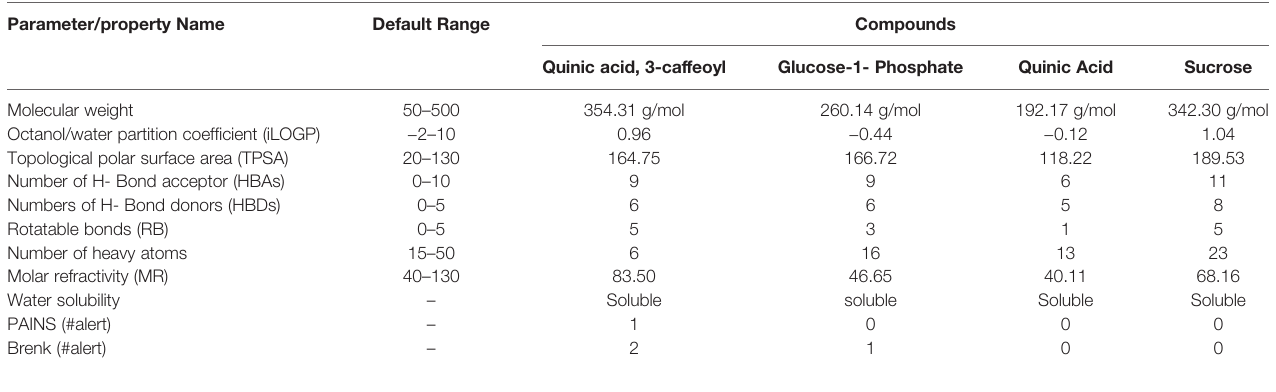
TABLE 6 | Calculated ADMET parameters of the